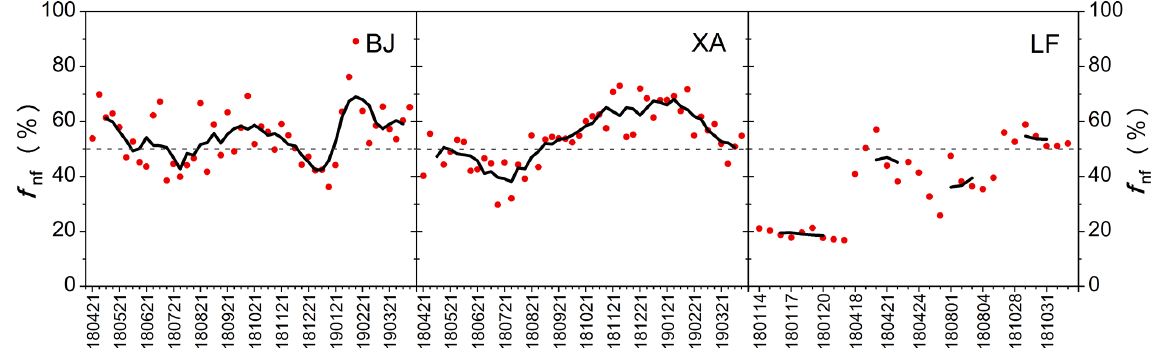
Figure 3. Variations in proportion of non-fossil sources ( f nf ) of carbonaceous aerosols at the sampling sites in BJ, XA, and LF. The red scatter dot represents the f nf of each sample, and the black solid line represents the sliding average f nf value of every five samples (date, “yymmdd”).